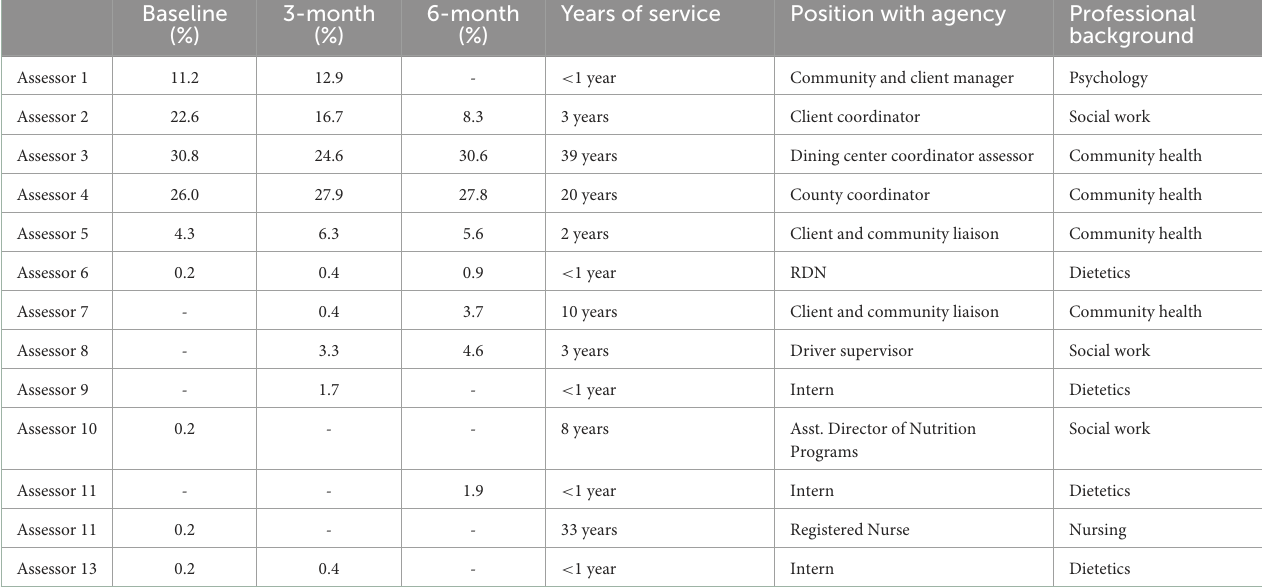
TABLE 2 Agency assessment staff and rates of Home Care Frailty Scale implementation at baseline, 3-months, and